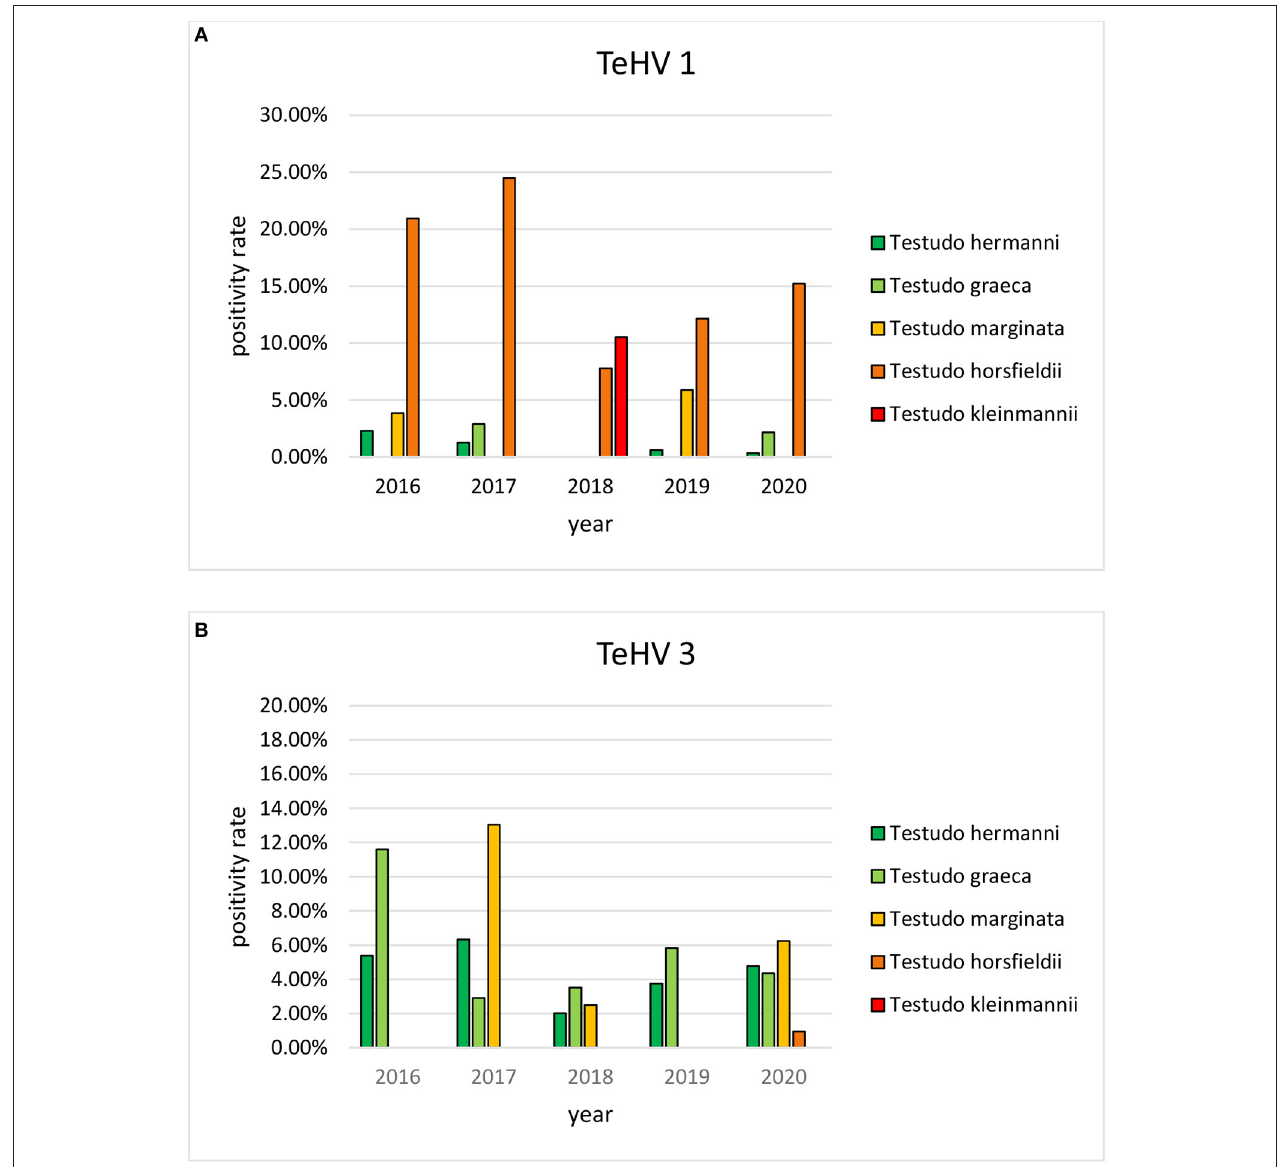
FIGURE 2 | Herpesvirus positivity rates in Testudo species (Hermann’s tortoises, T. hermanni , spur-thighed tortoises, T. graeca , marginated tortoises, T. marginata , Horsfield’s tortoises, T. horsfieldii , and Egyptian tortoises, T. kleinmanni) for the different years of sampling ( A TeHV 1 and B TeHV 3).